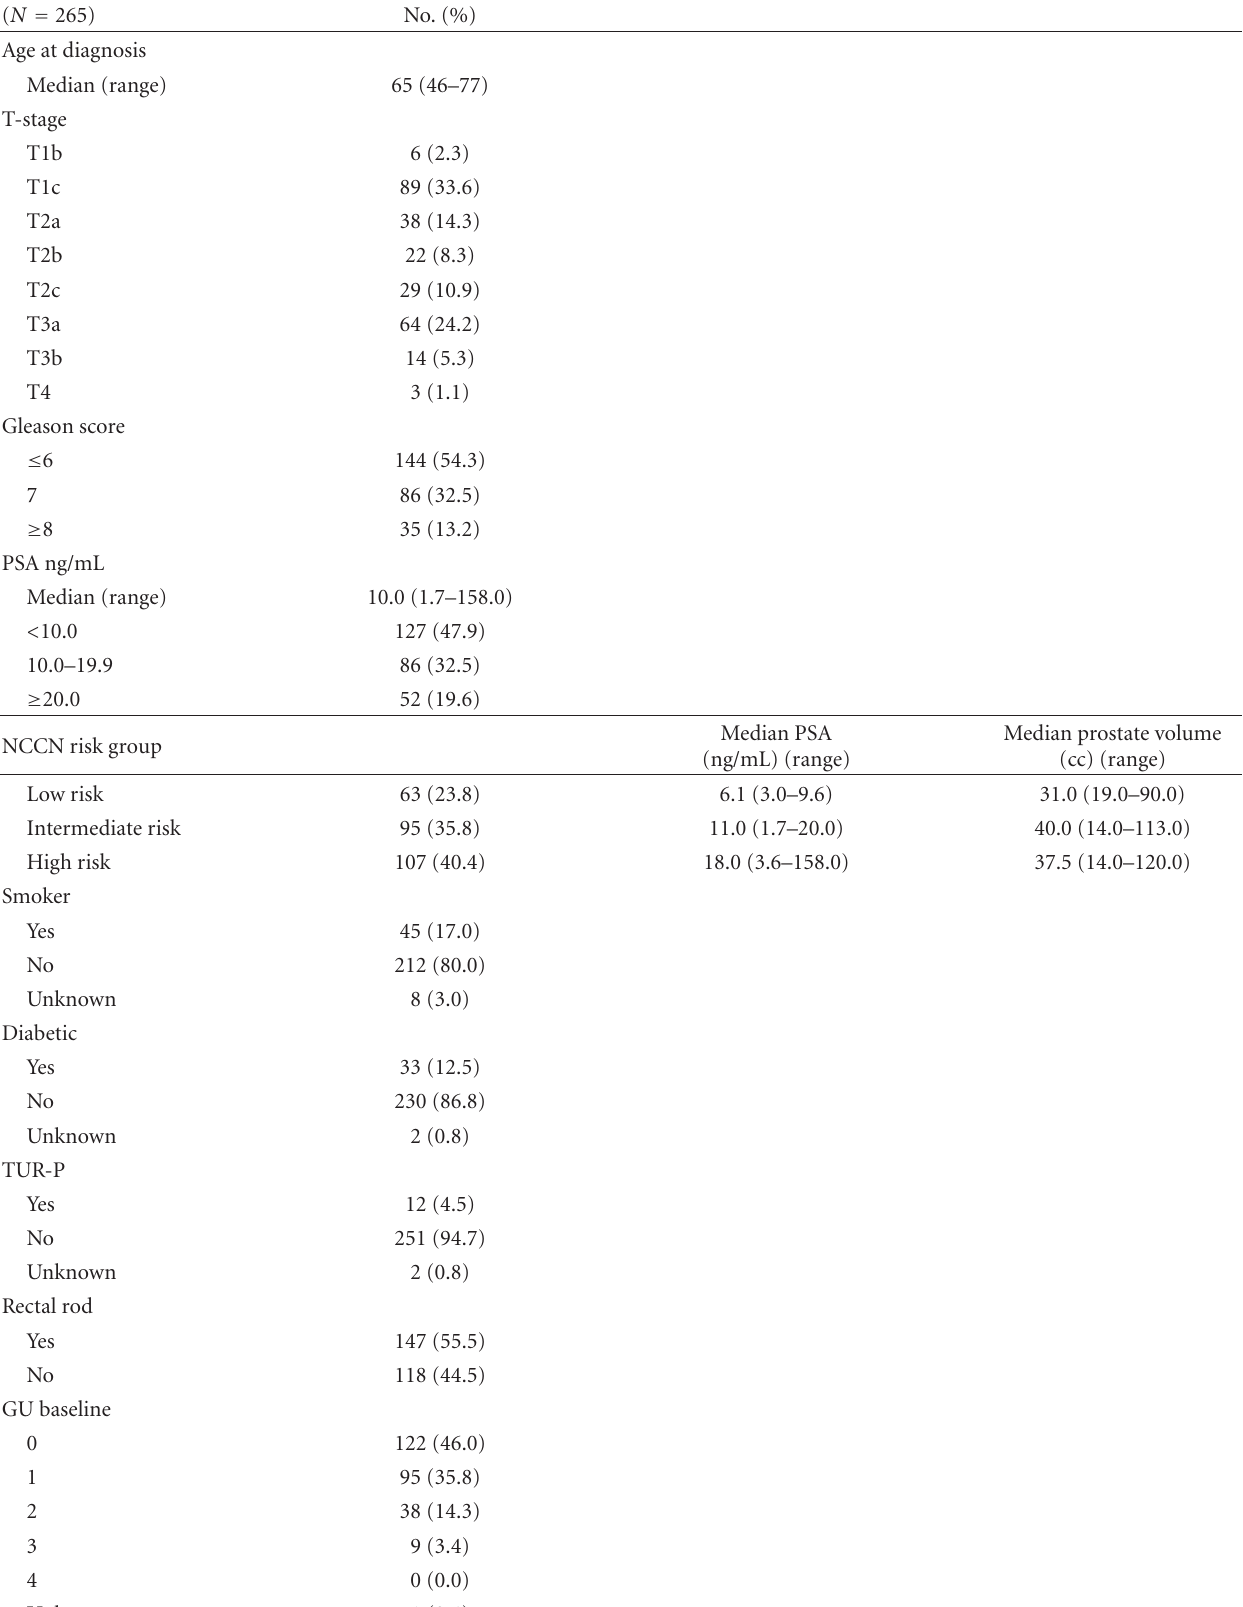
Table 1: Patient